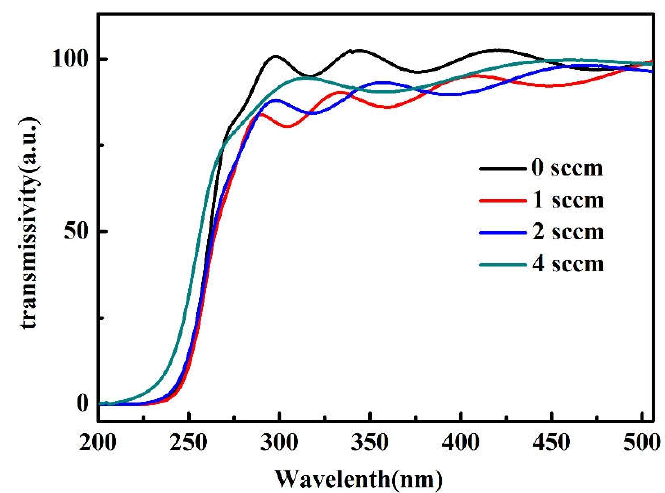
Figure 5. Transmission spectrum of the Ga 2 O 3.